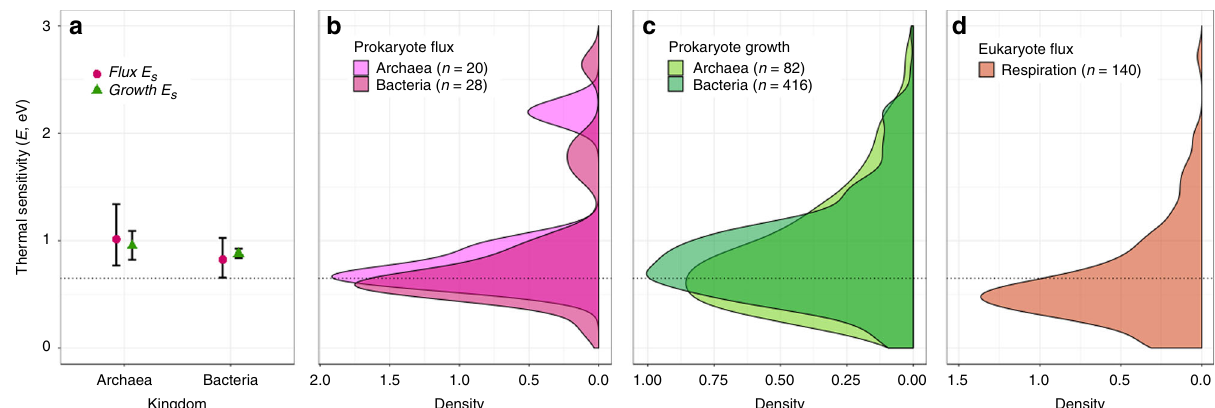
Fig. 5 Differences in short-term thermal sensitivity across taxonomic groups. a Comparison of the intra-speci fi c thermal sensitivity ( E S ) for growth (green triangles) and metabolic fl uxes (purple circles). Error bars represent 95% CIs. CIs for growth rate thermal sensitivity fall within those for metabolic fl uxes, and each sit above 0.65 eV (dotted line) for both archaea and bacteria (bacteria growth E S = 0.88 eV, n = 416; bacteria fl ux E S = 0.82 eV, n = 28; archaea growth E S = 0.95 eV, n = 82; archaea fl ux E S = 1.01 eV, n = 20). b Density plot of fl ux E S values for archaea and bacteria. c Density plot of growth rate E S values for archaea and bacteria. d Density plot of E S values for respiration rate TPCs in autotrophic eukaryotes, showing comparatively lower mean thermal sensitivity than those of the distributions for prokaryotes ( E S ¼ 0 : 67 eV, n = 381). Source data are provided as a source data fi le